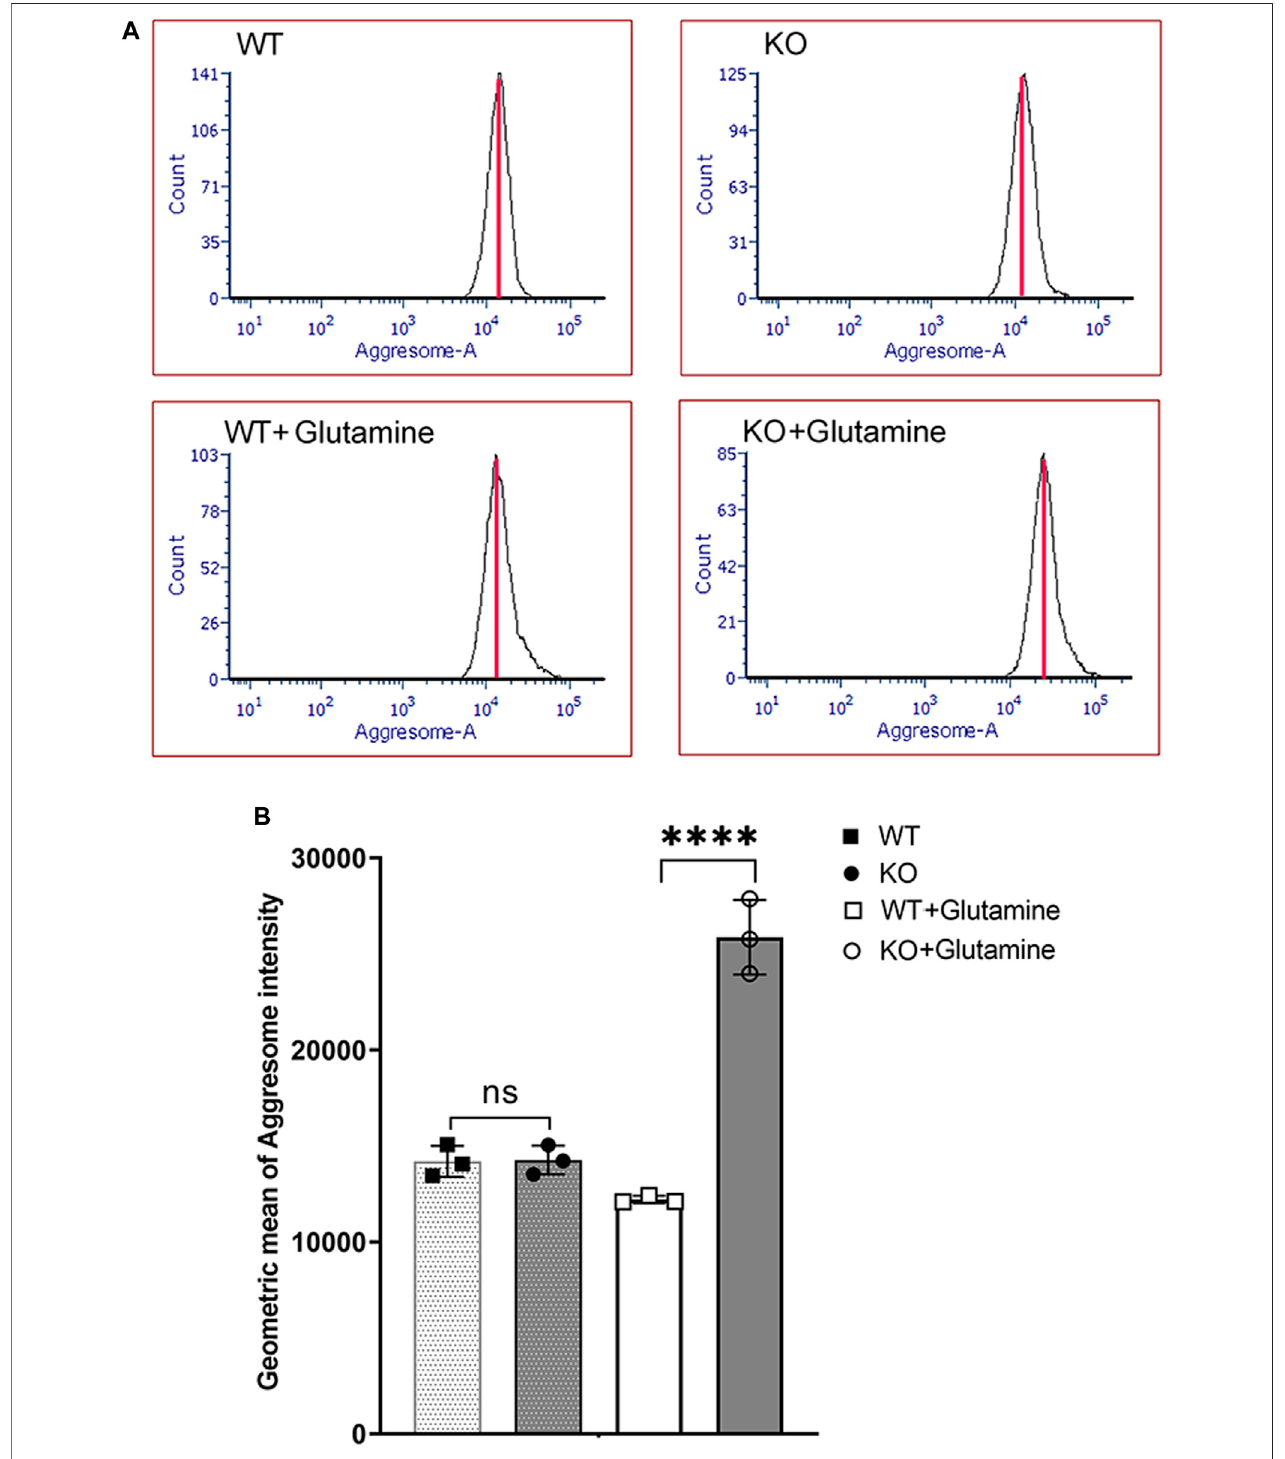
FIGURE 2 | Aggresome Formation in Immortalized WT and Slc4a11 KO MCEC. (A) Flow cytometry analysis of Slc4a11 WT and KO MCEC to determine the presenceofaggresomes(markerforunfoldedproteinsintheER). (B) Quanti fi cationoftheGeometricmeanofAggresomeIntensity.Studentst-test.n=3,**** p < 0.0001.